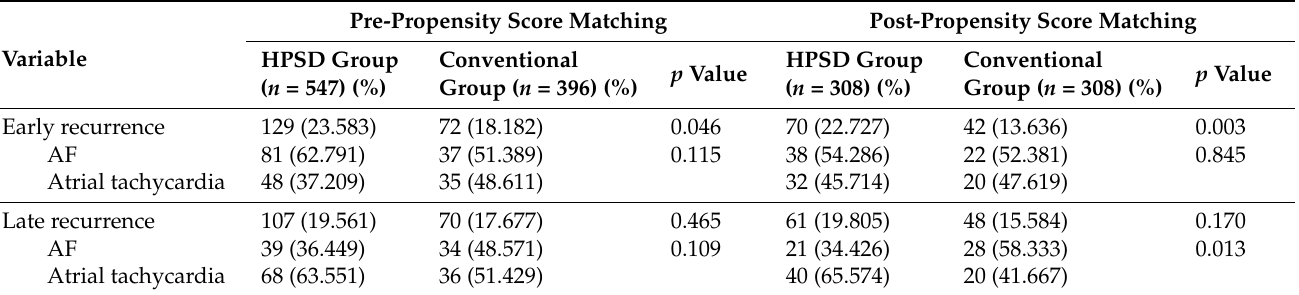
Table 3. Characteristics of recurrent atrial arrhythmias between two groups after a single